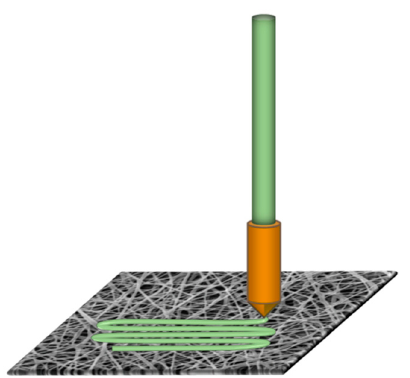
Figure 1. 3D printing with fused deposition modeling (FDM) technology on a polyacrylonitrile (PAN) nanofiber mat. The printing polymer PLA (here green) is delivered as a filament into the nozzle in a molten state and placed on the nanofiber mat.